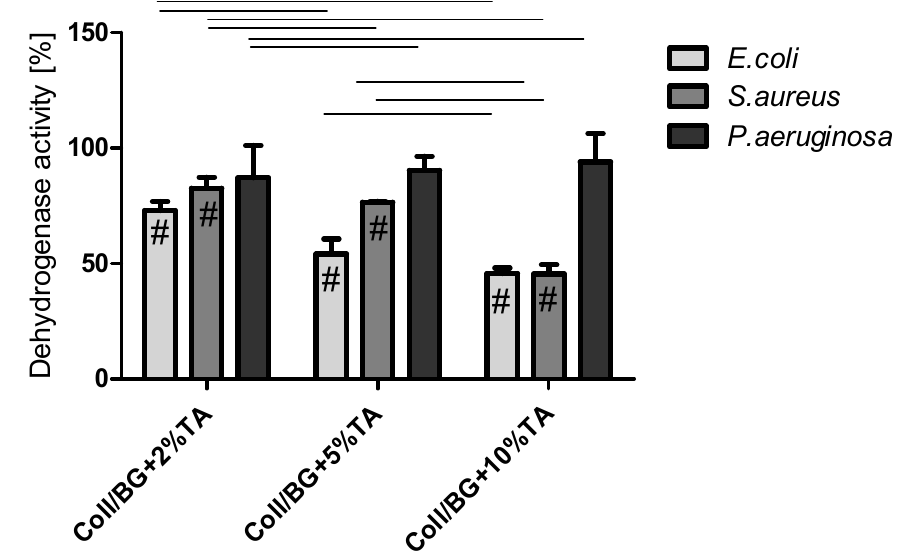
Figure 5. Dehydrogenase activity of Escherichia coli , Staphylococcus aureus , and Pseudomonas aeruginosa after 1 h of contact with hydrogels (#—significant difference from the control; lines between bars mark significant differences between groups.